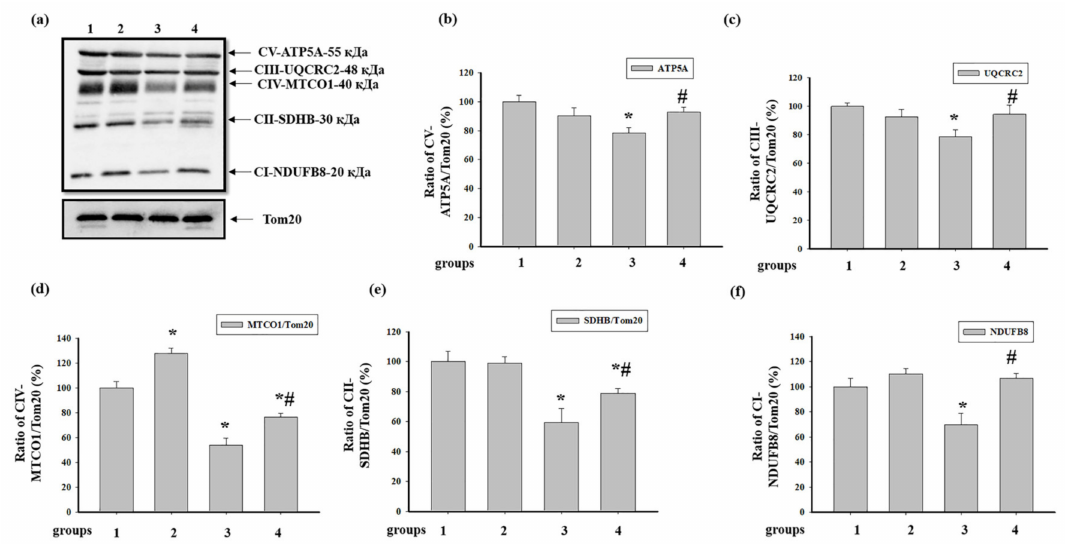
Figure 3. E ff ect of the administration of AST and ISO on the level of subunits of mitochondrial respiratory chain complexes in rat heart mitochondria. Protein samples were extracted